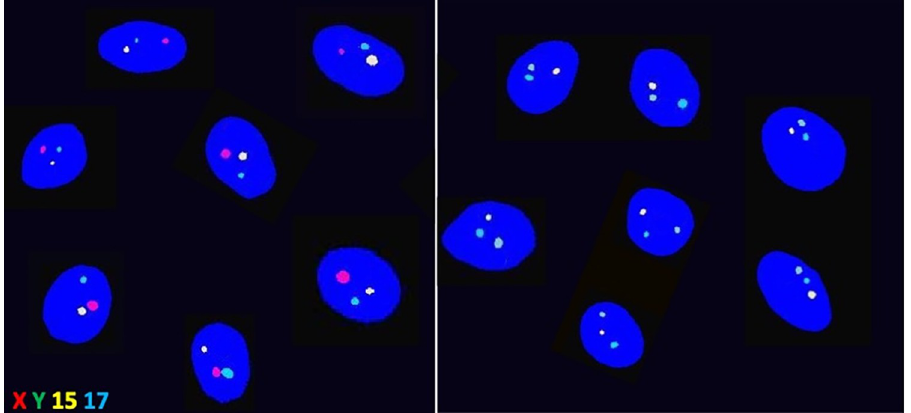
Fig 4. FISH assessment. For couples selecting for female sex, our processing method was able to yield an increased proportion of X-bearing spermatozoa (left). Similarly, our method yielded a greater proportion of Y-bearing spermatozoa for couples selecting for male sex